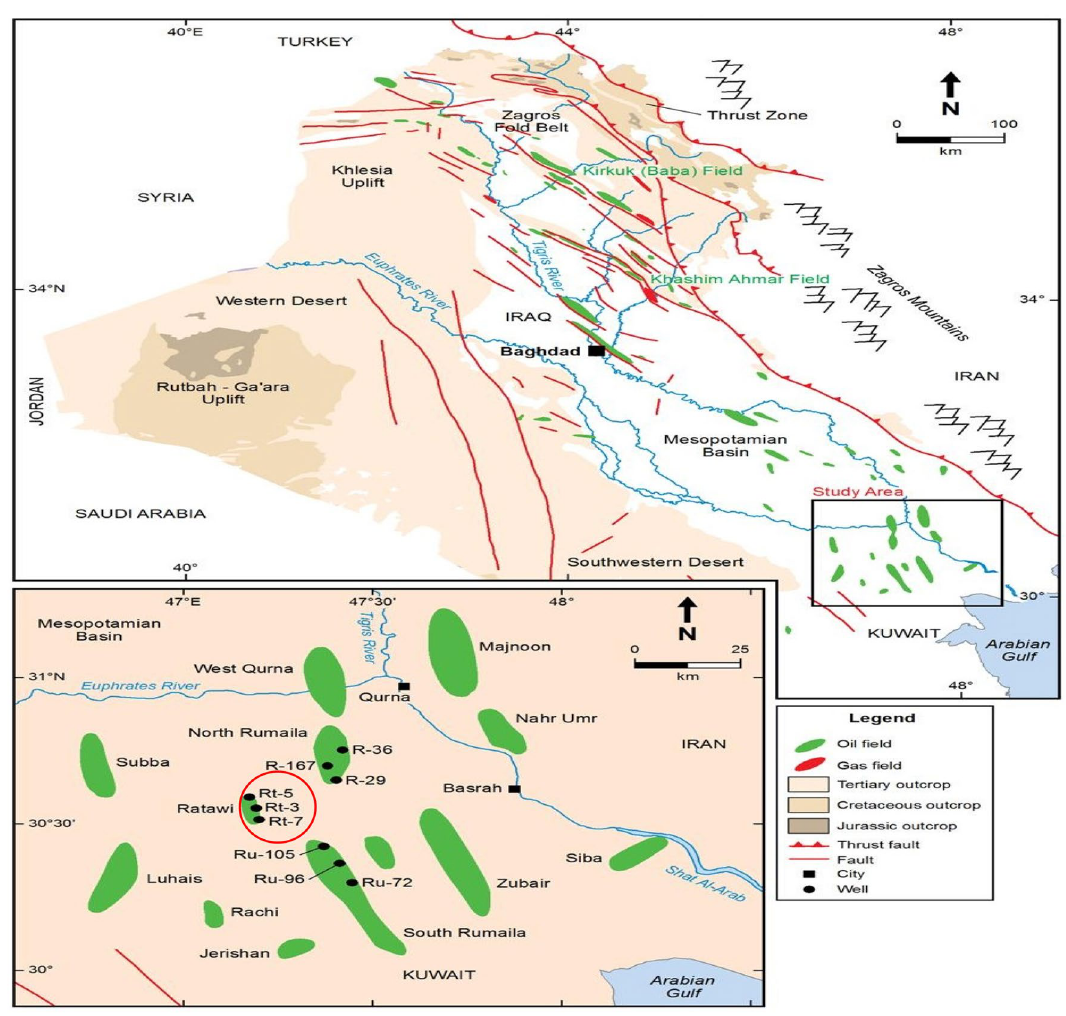
Fig. 1 Map location for studied field (Al-Ameri et al.